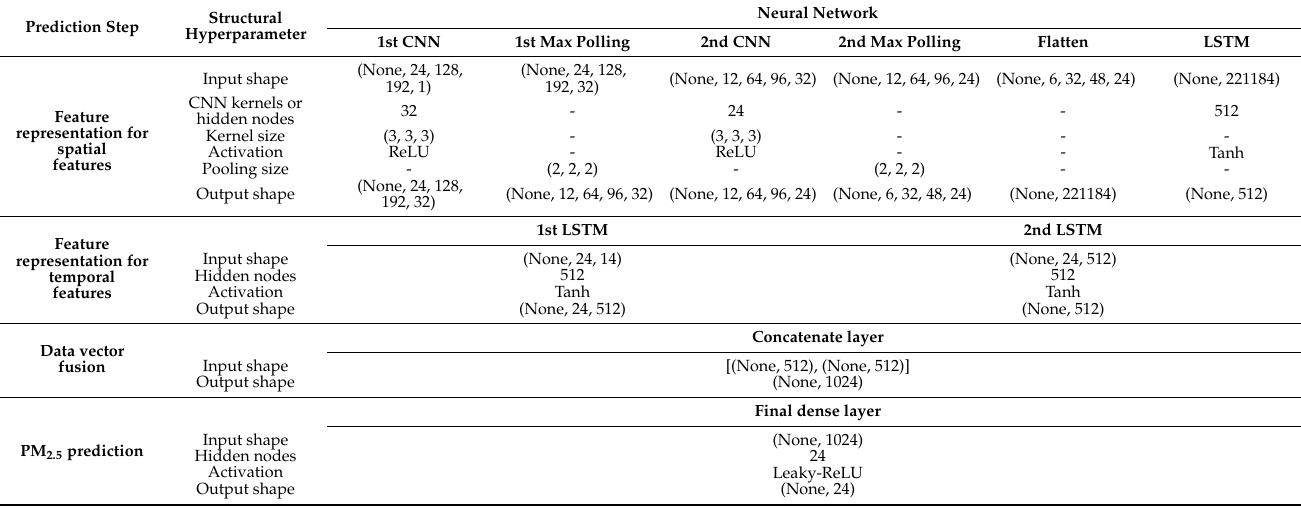
Table 3. Configuration of the CNN+LSTM hybrid neural network